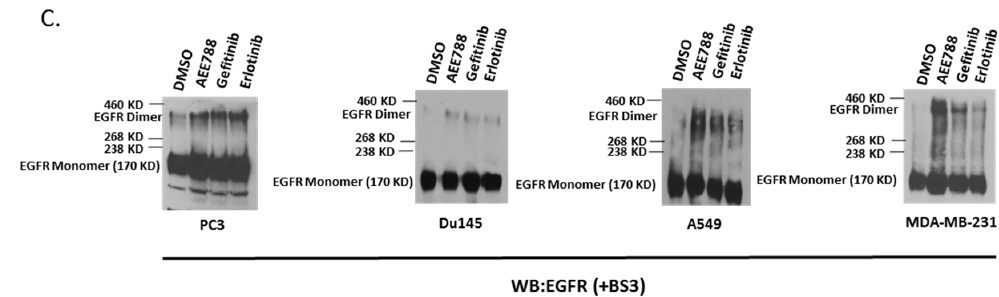
Figure 1. Acute treatment with tyrosine kinase inhibitors (TKIs) induce membrane-tethered epidermal growth factor receptor (EGFR) dimerization. ( A ) Gefitinib and erlotinib inhibit EGFR’s kinase activity in a dose-dependent manner. EGFR-positive cells (PC3, Du145, A549, and MDA-MB-231) were treated with an increasing concentration of either gefitinib or erlotinib acutely for 24 h. The cell lysates were collected for Western blot; ( B ) graphs represent the quantification of pY1173 EGFR from panel ( A ) and are normalized to the corresponding EGFR to β -actin fold change for all the treatments; ( C ) TKIs induce EGFR dimerization. PC3 and Du145 were treated with 5 µM concentration of TKIs (AEE788, gefitinib, and erlotinib), and A549 and MDA-MB-231 were treated with 10 µM of TKI in addition to vehicular control in serum-free media (absence of ligands) for 24 h. The degrees of EGFR dimerization due to TKI treatments were analyzed using membrane crosslinking reagent BS3. The cell lysates were resolved on sodium dodecyl sulfate polyacrylamide gel (SDS-PAGE) in reducing conditions followed by Western blot.